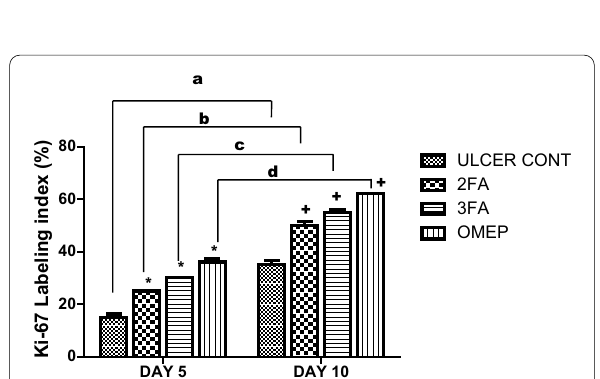
Fig. 16 Labelling index of Ki-67 in healing ulcerated stomach treated with folic acid and Omeprazole (* p < 0.05 cf ulcer control; a–d p < 0.05 cf. each group on day 10). ULCER CONT Ulcer control, 2FA 2 mg/kg Folic acid, 3FA =